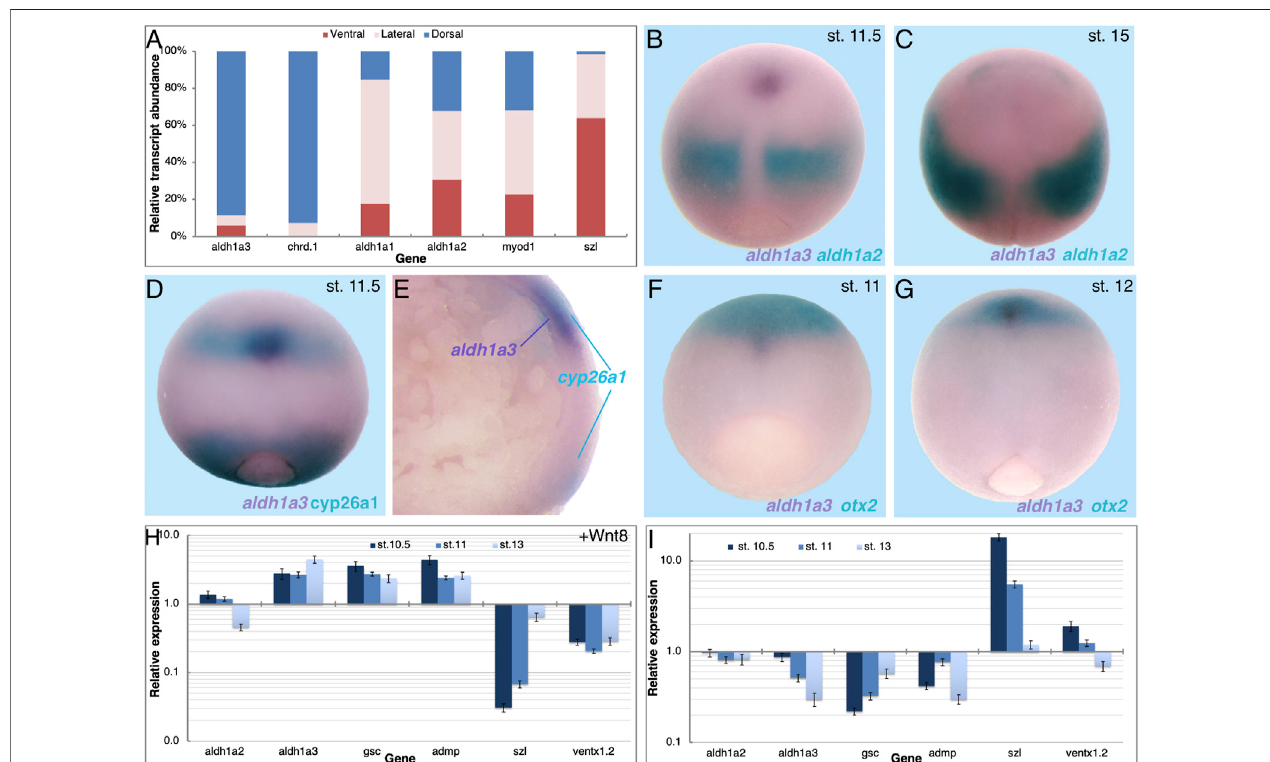
FIGURE 4 | Expression of aldh1a3 in the migrating LEM/PCM cells. (A) Mid-gastrula embryos (st. 11) were dissected into dorsal, lateral, and ventral regions, and RNAwasextractedfromeach region.Therelative abundanceof aldh1a1 , aldh1a2 ,and aldh1a3 wasstudiedbyqPCR.Theaccuracyofthedissections wasdetermined by qPCR of chrd.1 , myod1 , and szl as dorsal, lateral, and ventral markers, respectively. In comparison to the szl transcript distribution, all other genes had a signi fi cantly different distribution, p < 0.0001 using the Fisher exact probability test. Spatial expression pattern comparison between aldh1a3 and aldh1a2 (B,C) , aldh1a3 and cyp26a1 (D,E) , and aldh1a3 and otx2 (F,G) . (B – D,F,G) dorsal view, anterior to the top. (H,I) Embryos were injected with mRNA encoding WNT8a (H) or BMP4 (I) and sampleswerecollectedduringearlyandmid-gastrula,andearlyneurulastages(st.10.5,11,and13).qPCRanalysiswasperformedfor aldh1a2 and aldh1a3 ,thedorsal markers gsc and admp , and the ventral genes szl and ventx1.2 . Relative expression was normalized to levels in control embryos. Groups of injected embryos were incubated to tailbud stages to determine their dorsoanterior index (DAI) (Kao and Elinson, 1988). wnt8a , DAI = 5.67; bmp4 , DAI = 3.64.